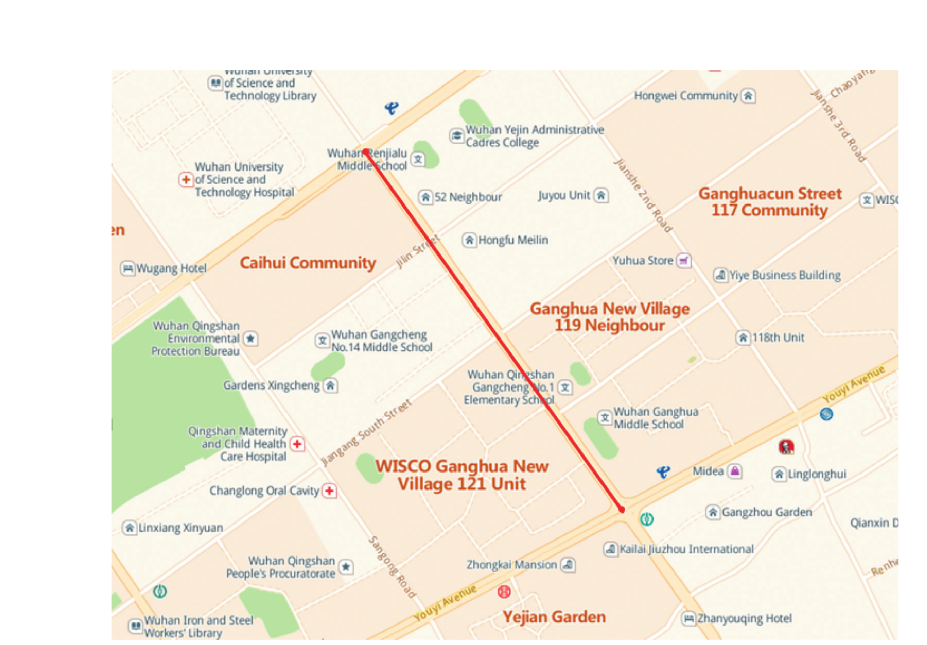
Figure 5: Details of the Jianshe Road section. Table 11: Traffic flow survey data for Jianshe Road.